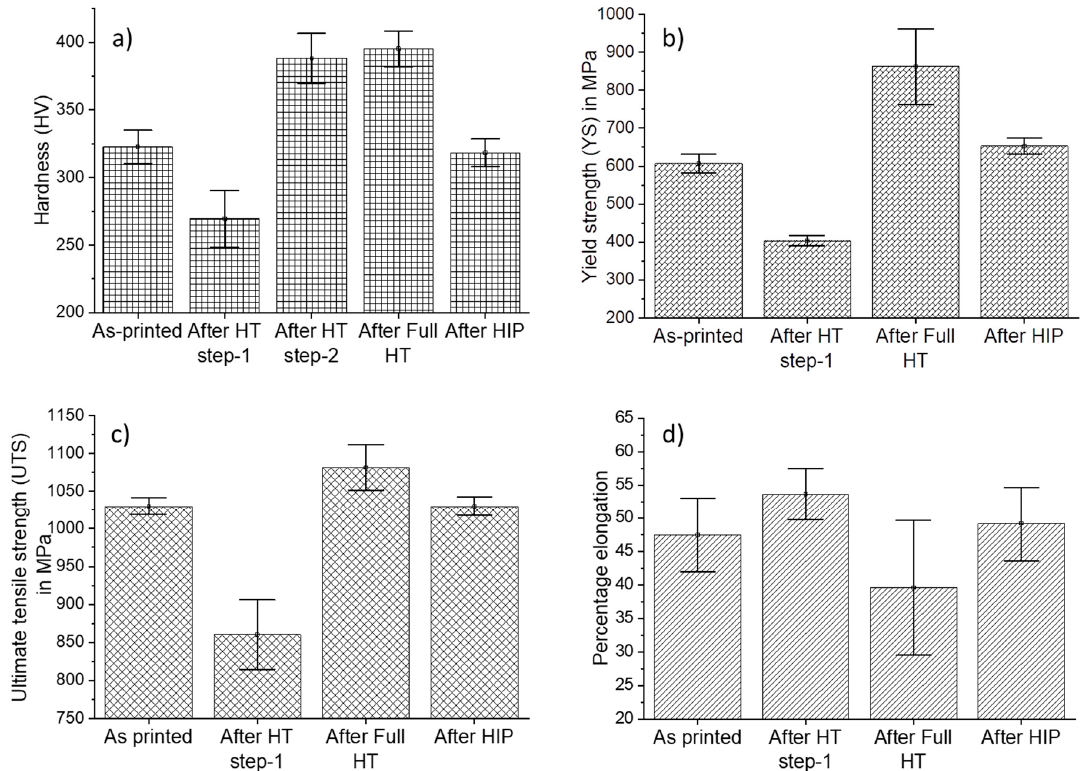
Figure 7. ( a ) Hardness values after every heat-treatment step; ( b ) yield strength of samples as-printed, after full heat-treatment, and after HIP; ( c ) ultimate tensile strength (UTS) of samples as-printed, after full heat-treatment, and after HIP; and ( d ) percentage elongation of samples as-printed, after full heat-treatment, and after HIP.